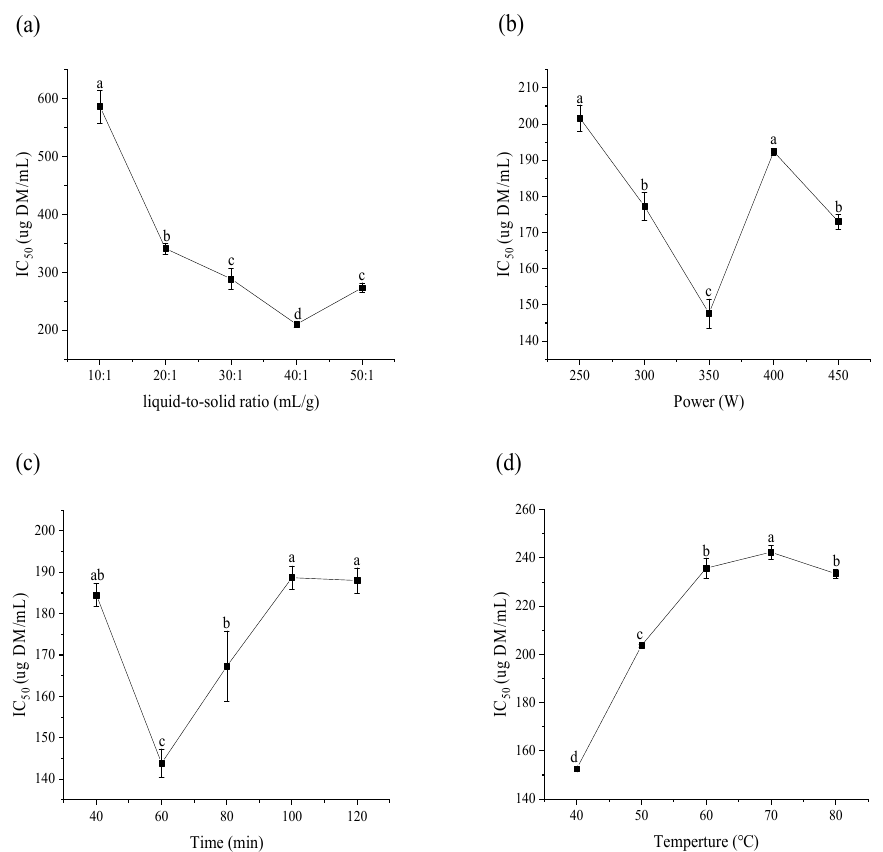
Figure 2. E ff ects of liquid-to-solid ratio ( a ), ultrasonic power ( b ), extraction time ( c ), extraction temperature ( d ), on the α -glucosidase inhibitory ability (IC 50 ) of CDL extracts.